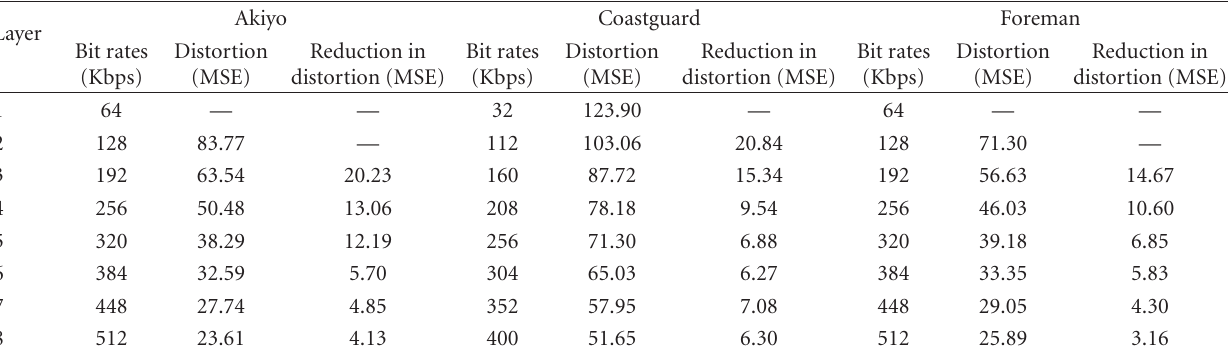
Table 1: Standard video profiles—set I.